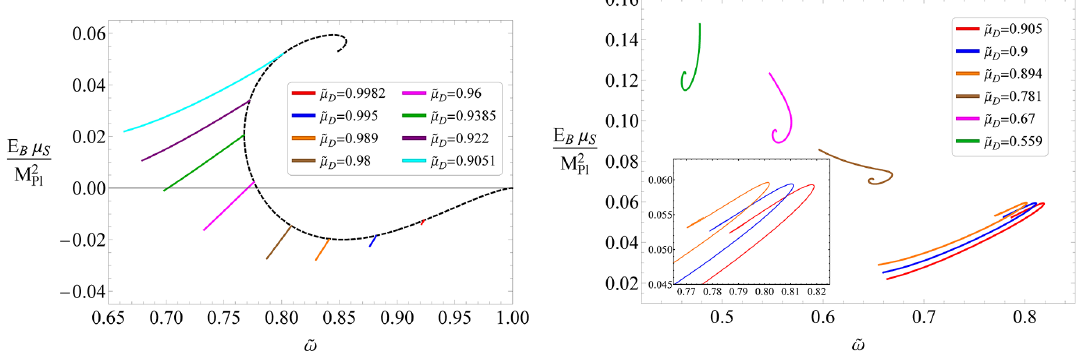
Figure 11. Left panel : the binding energy E B of the one-branch solution family as a function of the synchronized frequency ˜ ω for several values of the Dirac field mass ˜ µ D . Right panel : same as left panel for the multi-branch solution family. The black dashed line represents the S 0 state solutions. All solutions have ˜ µ S = 1